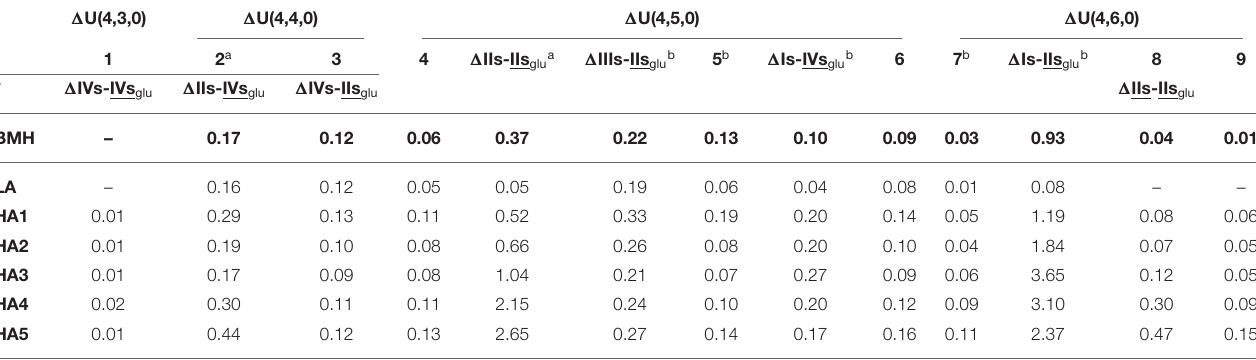
TABLE 4 | Quantification ( ± 10%) of undetermined tetrasaccharide building blocks (% w/w) for bovine mucosal heparin (BMH; starting heparin) affinity fractions using ion-pair liquid chromatography/mass spectrometry (LC/MS). 1 U(4,3,0)